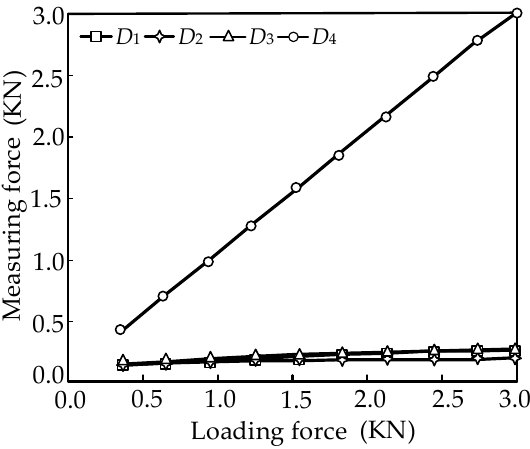
Figure 25. Calibration on the fourth branch.